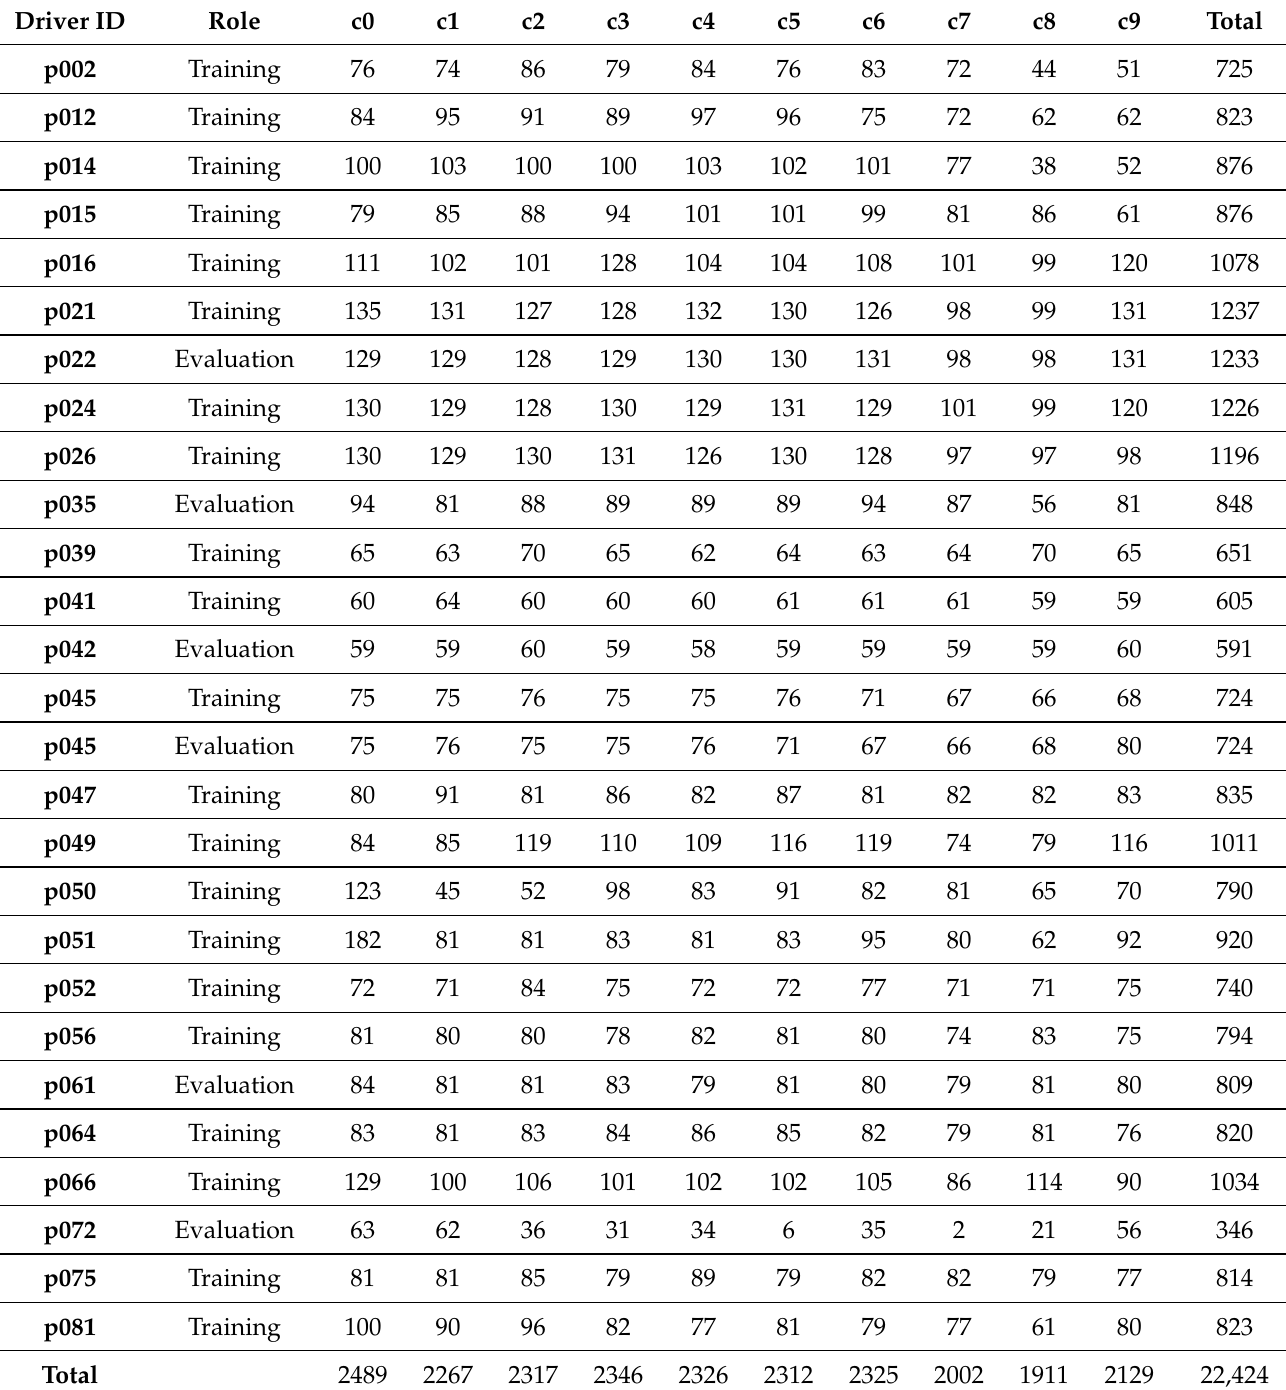
Table 3. Details of State-Farm-Distracted-Driver-Detection